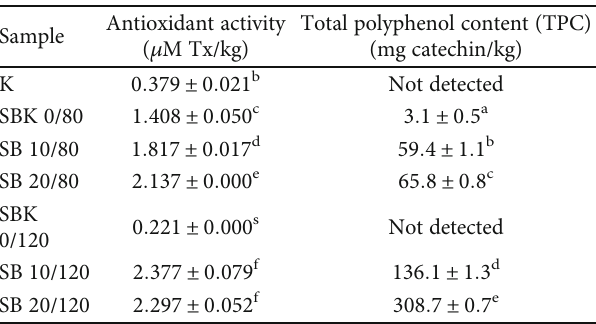
Table 3: Antioxidant activity and total polyphenol content in the examined bread samples (in dry matter).